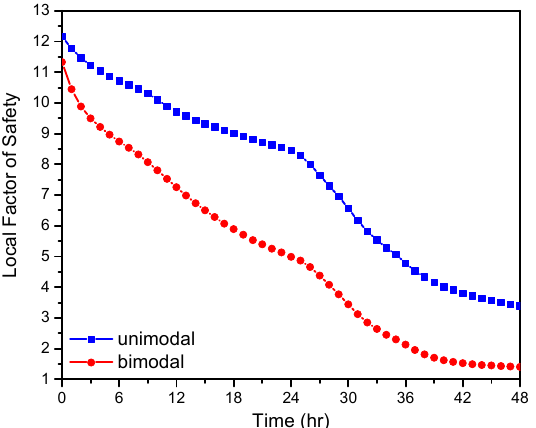
Figure 12. The changes of the LFS in the unimodal and bimodal models with time at a depth of 0.85 m.